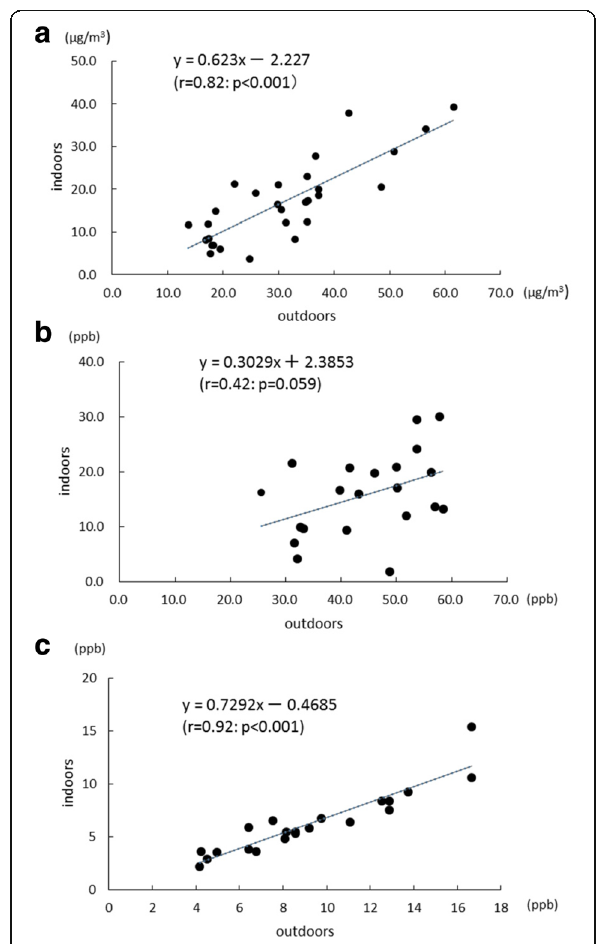
Fig. 2 Correlation of indoor and outdoor concentrations of a PM 2.5 , b